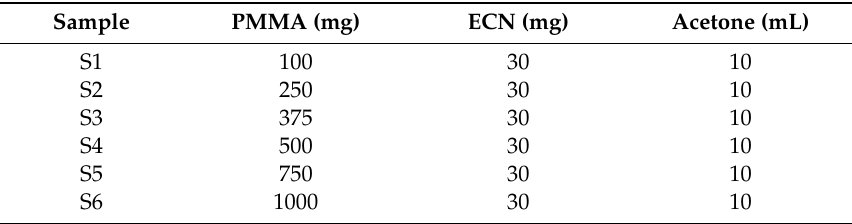
Table 1. Experimental setup